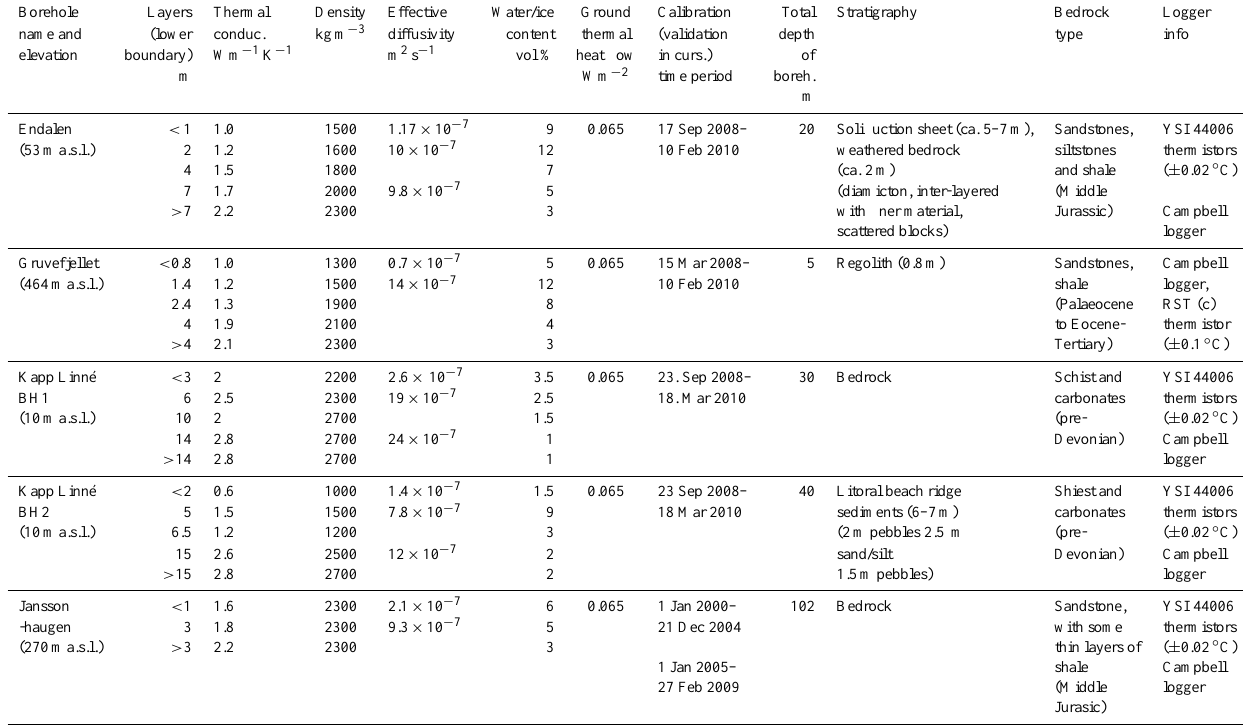
Table 1. Calibration parameters used for ground temperature modelling. Thermal conductivity and bedrock density were selected from published literature and fine-adjusted during calibration. Effective diffusivity was estimated based on the measured ground temperatures Borehole Layers Thermal Density Effective Water/ice Ground Calibration Total Stratigraphy Bedrock Logger name